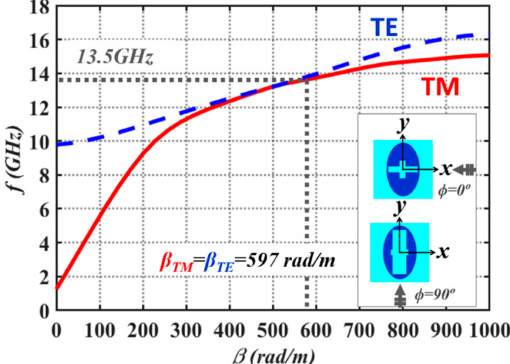
Figure 5. Frequency dispersion properties for TM and TE modes when impinging on pixel B at φ = 0 ◦ . Curves agree with the frequency dispersion of the modes for pixel C within φ = 90 ◦